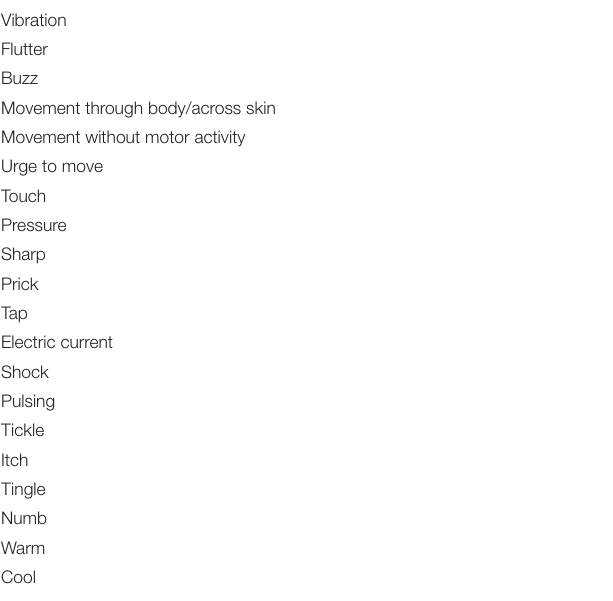
TABLE 1 | List of sensory